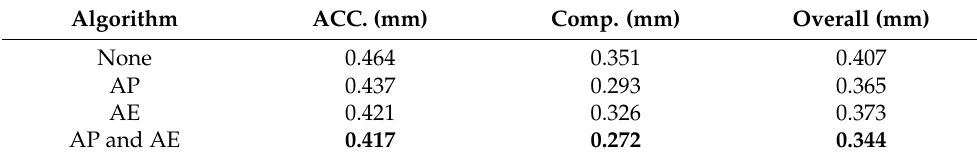
Table 5. Effect of adaptive propagation and adaptive evaluation on experimental results.